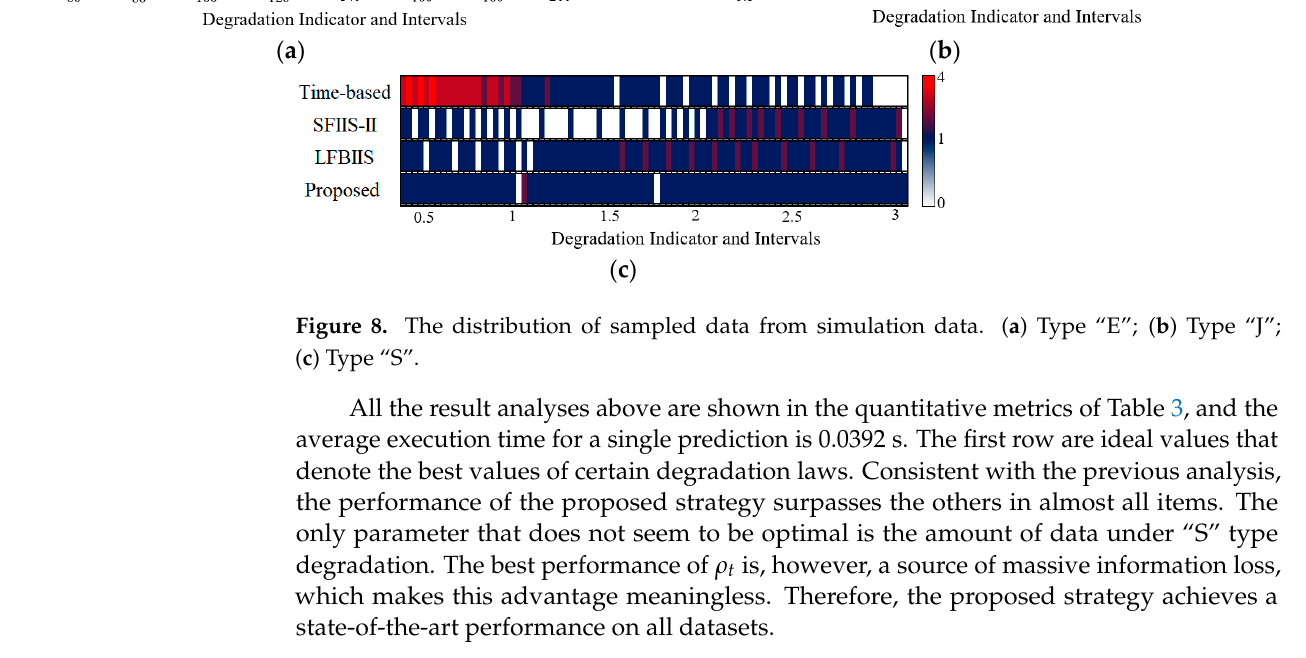
Table 3. The results of performance metrics for simulation